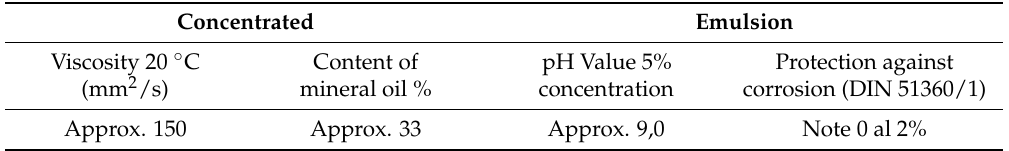
Table 3. Properties of Rhenus ® FU 70 W coolant.